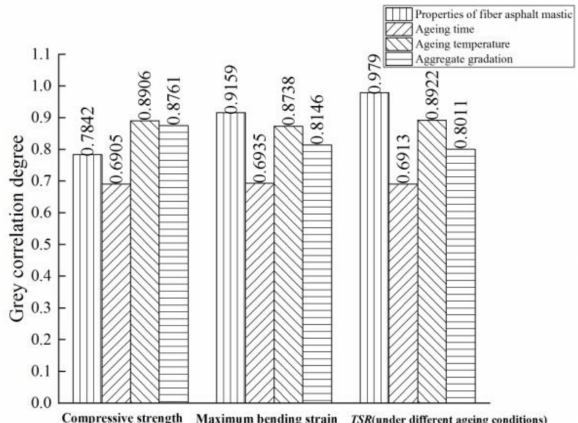
Figure 12. Grey correlation analysis results of influencing factors of ageing durability.